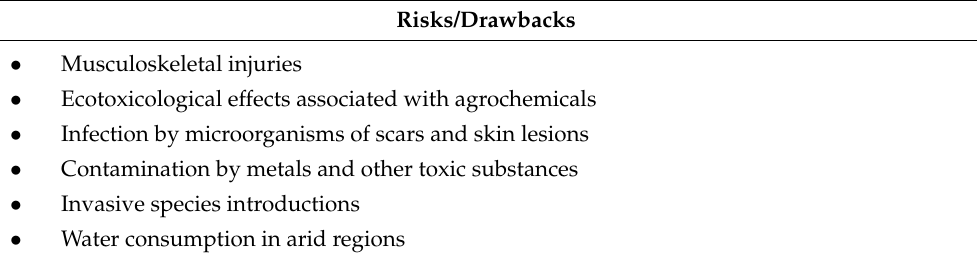
Table 4. Risks and drawbacks of home gardens and home